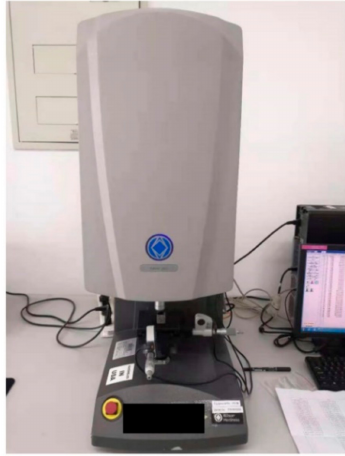
Figure 32. Vickers hardness testing system TUKON2500.